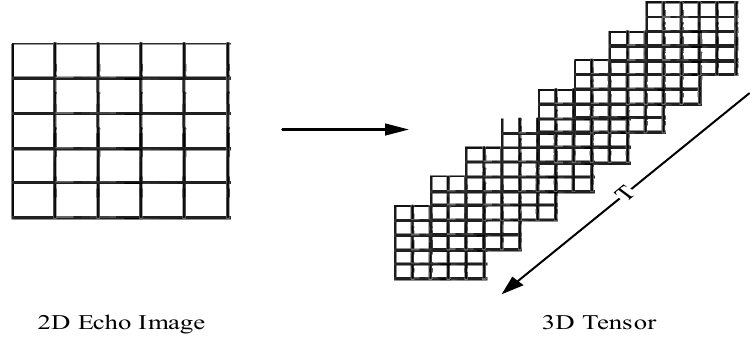
Figure 2. Dimension construction of radar echo data.